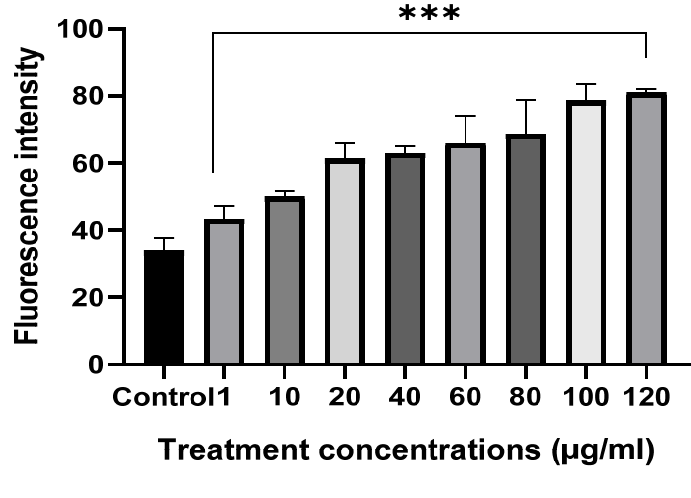
Figure 10. Effect of MWCNT-reinforced PMMA nanocomposites with hydroxyl functionalization on intracellular ROS levels in the KB Cell ( A ) Fluorescence microscopic images with green fluorescence demonstrating intracellular ROS generation in KB cells using DCFH-DA labelling ( B ) GraphpadPrism version 8 and intracellular ROS pictures were evaluated using ImageJ software. *** p < 0.001 denote highly significant data.